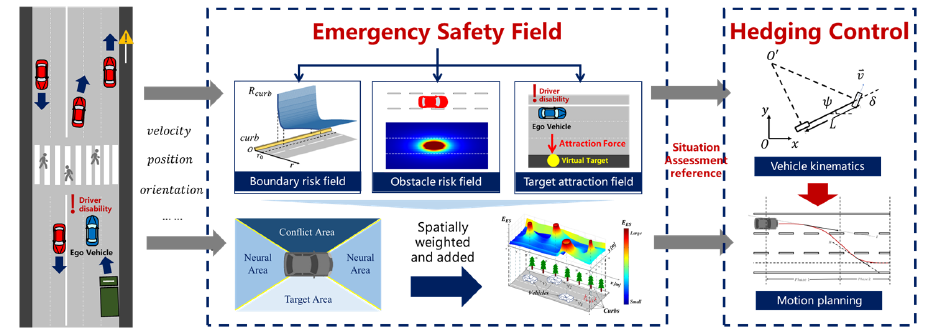
Figure 2. The framework of the autonomous danger avoidance system.